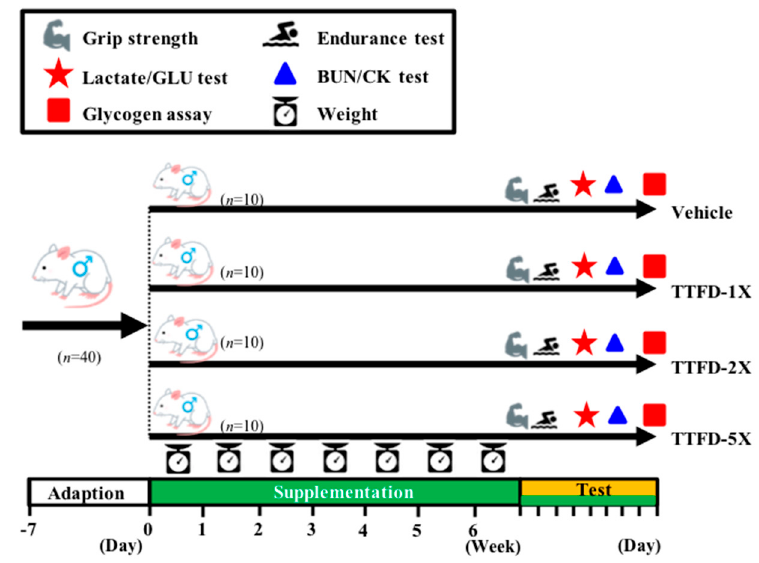
Figure 2. Experimental designs for the effects of thiamine tetrahydrofurfuryl disulfide (TTFD) on exercise adaption. The animals were randomly assigned to the indicated four groups (Vehicle, TTFD-1X, TTFD-2X, and TTFD-5X) and consecutively supplemented the TTFD until the end of the experiments. The physical capacities and related biochemistries were assessed within test duration.